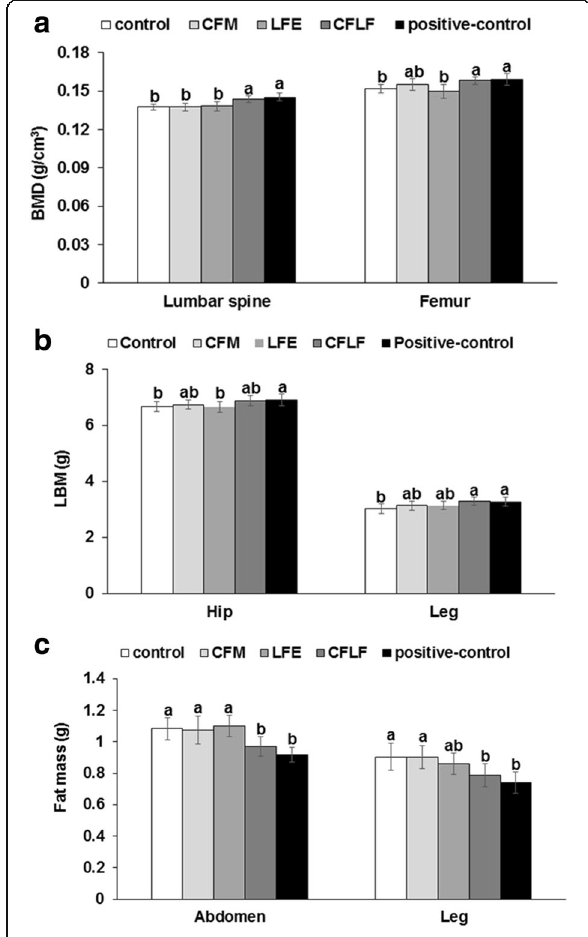
Fig. 1 Body composition including bone mineral density (BMD), lean mass (LM), and fat mass (FM) measured by DEXA. Control, OVX rats fed a high-fat diet (HFD) with 1% dextrin; CFM, OVX rats fed an HFD with 1% lyophilized cauliflower mushroom; LFE, OVX rats fed an HFD with 0.1% L . fermentum plus 1% dextrin; CFLF, OVX rats fed an HFD with 1% CFM plus 0.1% L . fermentum ; positive-control, OVX rats fed an HFD with 1% dextrin plus 30 μ g/kg body weight 17 β -estradiol. At the end of the experimental period, BMD ( a ) in the lumbar spine and femur and LM ( b ) and FM ( c ) in the abdominal and leg regions were measured by DEXA. Values are expressed as means ± SD ( n = 12). Different letters represent a significant difference in Tukey test at p <